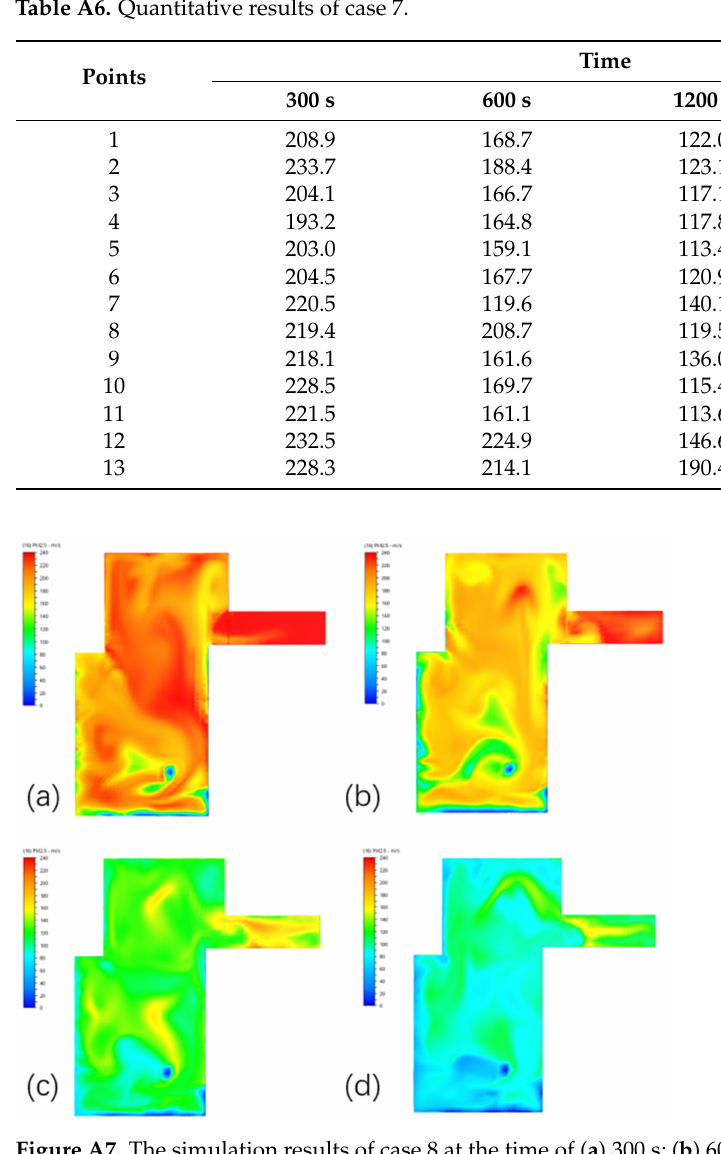
Figure A7. The simulation results of case 8 at the time of ( a ) 300 s; ( b ) 600 s; ( c ) 1200 s; ( d ) 1800 s. Table A7. Quantitative results of case